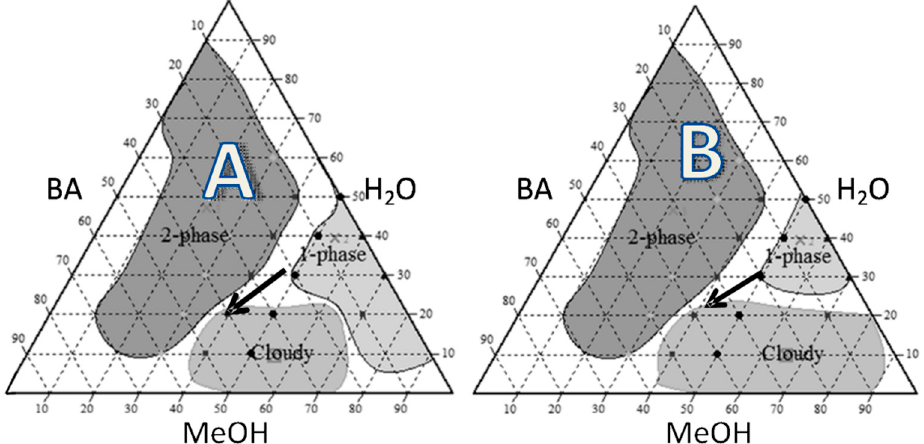
Figure 1. Butyl acetate–methanol–Water pseudoternary phase diagrams obtained in the presence of ( A ) inulin (INU) at 0.75 w / w % and, ( B ) a mix of INU at 0.5 w / w % and colistin (COLI) 0.5 w / w %. The arrow in the diagram indicates the relative change in solvent composition that should occur during the spray drying.